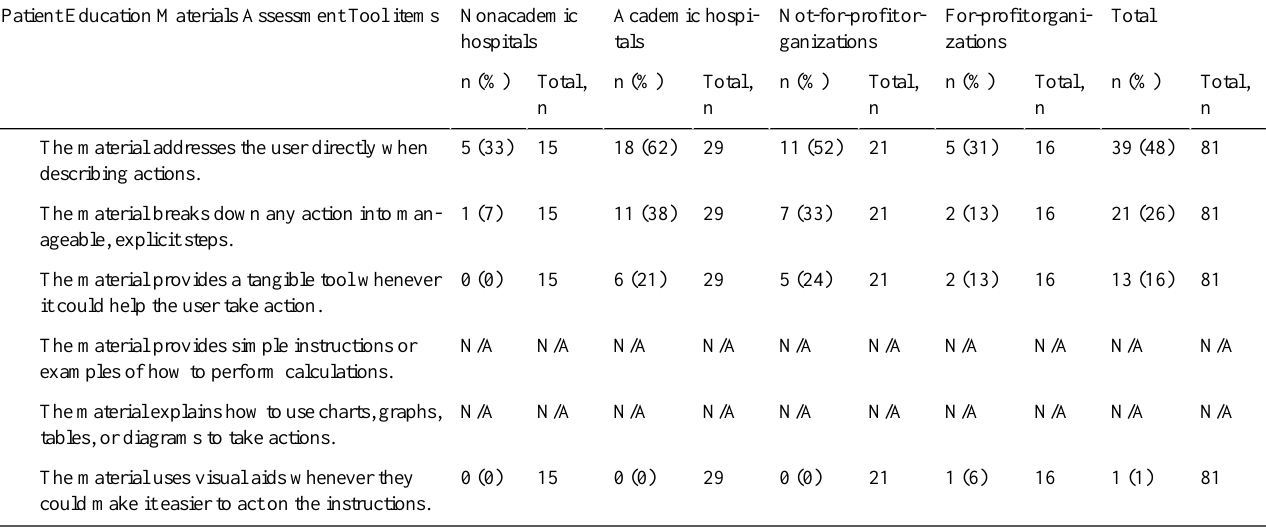
keywords used, number of screened websites, inclusion criteria, parameters evaluated, and assessment tools. Some studies focus only on one parameter (eg, readability) [21,39-41], whereas others address quality and content as well [23,24,28,42-44]. Multiple quality and readability assessment tools exist, the selection of which relies on the discretion of the study